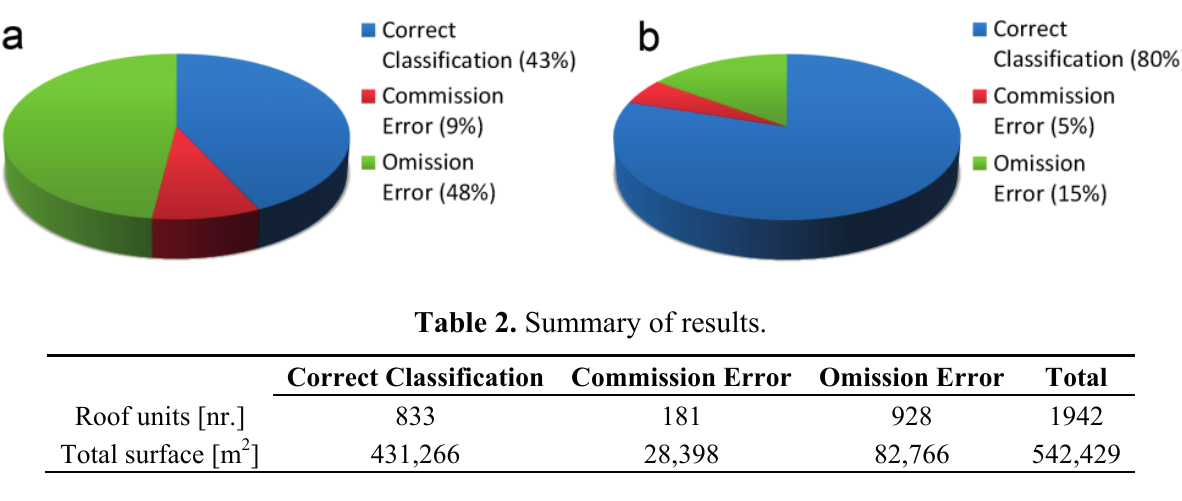
Figure 5. Overall classification results for the whole study area: ( a ) number of asbestos-cement roofs; ( b ) percentage of surface (m 2 ) of asbestos-cement roofs.